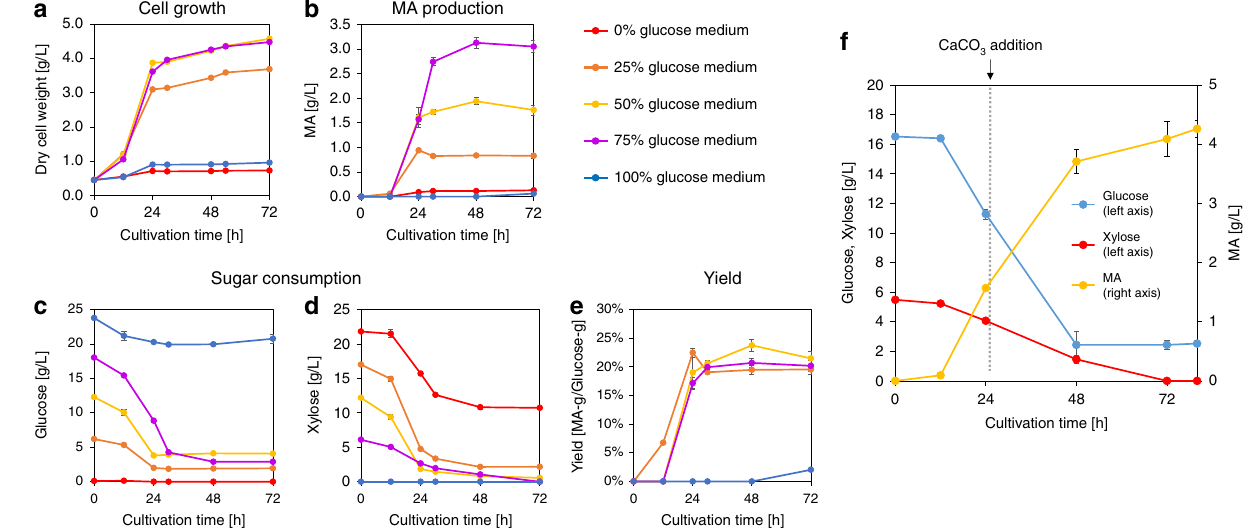
Fig. 7 Culture pro fi les of the GX1xMA strain in M9 minimal medium containing 20 g L − 1 sugar(s) and 5 g L − 1 yeast extract. a Bacterial cell growth. b Produced amounts of MA. c Glucose consumption. d Xylose consumption. e Production yield of cis,cis -muconic acid (MA) from glucose (g of produced MA g − 1 of consumed glucose). Red, orange, yellow, purple, and blue symbols indicate the results of cultivation in 0%, 25%, 50%, 75%, and 100% glucose medium, respectively, in a – e . f Culture pro fi les of the GX1xMA strain with the addition of CaCO 3 . The fi nal sampling time is after 80 h cultivation. Blue, red, and yellow symbols indicate the glucose concentration, xylose concentration, and the produced amount of MA, respectively. The data are presented as the average of three independent experiments, and error bars indicate standard errors. Source data are provided as a Source Data fi